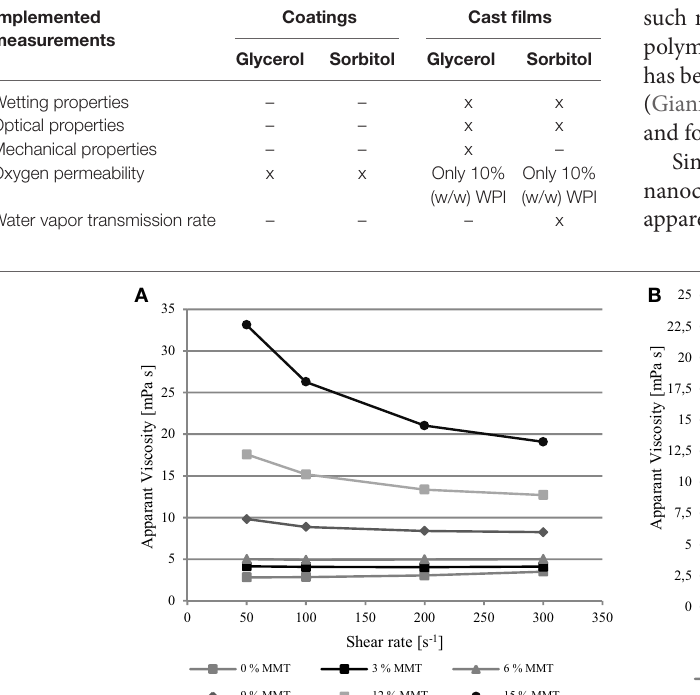
TaBle 1 | Implemented measurements for whey protein isolate (WPI)-based montmorillonite nanocomposite cast films and coatings. implemented